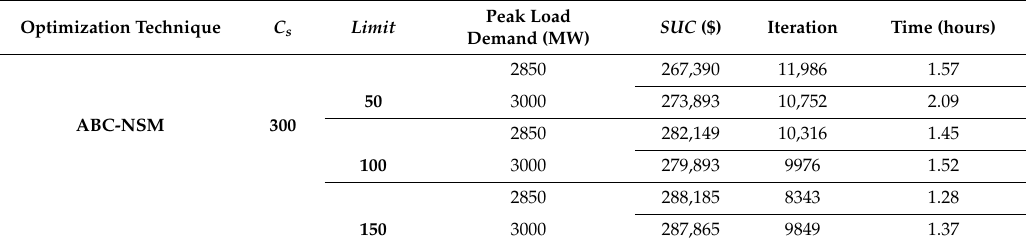
Table 3. Results of the SUC based on selected values of Cs = 300 and its computation time for every limit specified in MABC-NSM technique for peak load demands of 2850 MW and 3000 MW.